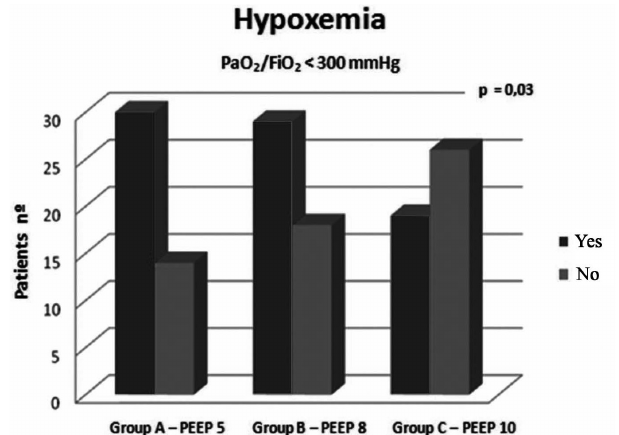
Fig. 1 - Hypoxemia frequency, by group, in patients undergoing CABG and ventilated with different PEEP levels in immediate postoperative period. PaO - arterial oxygen partial pressure, FiO 2 fraction, PEEP - Positive end-expiratory pressure. Chi-square